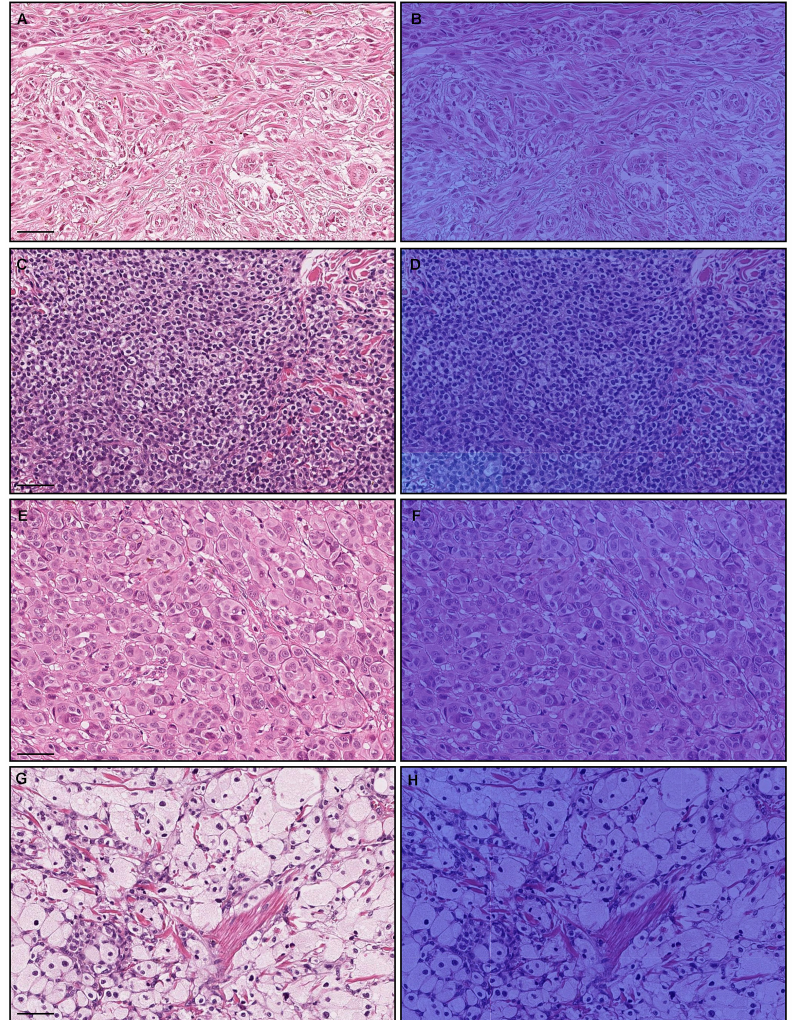
Figure 8. An example of melanoma false negative using the × 20, 512 × 512 px model. Histopatho- logically amelanotic variants of melanoma cells without melanin ( A , C , E , G ) were false-negatively predicted as melanoma ( B , D , F , H ) at the tile level. Red indicates a high probability and blue indicates a low probability. Scale bars: 50 µ